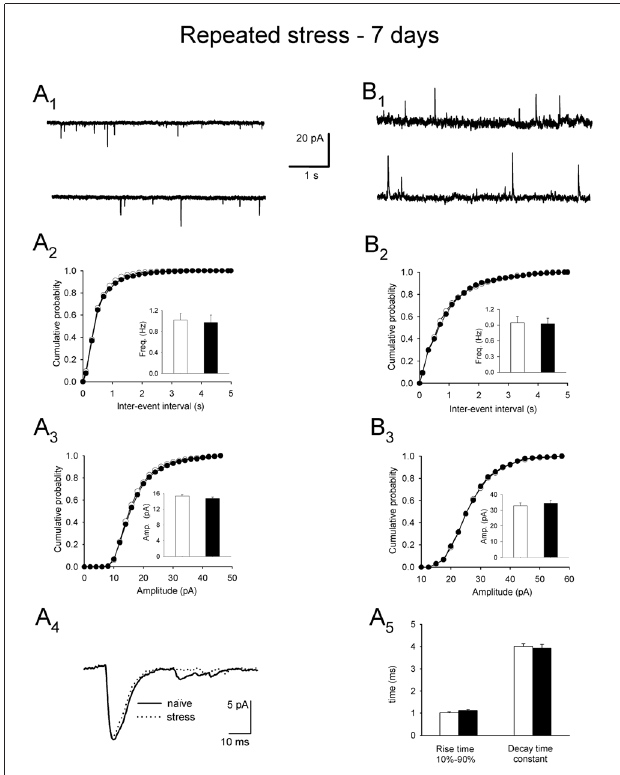
respectively; n = 8 and 8, t = 0.6578, df = 15, p = 0.212). There were also no differences in the mean mEPSC amplitude (15.31 ± 1.121 pA vs. 15.14 ± 0. 894 pA, respectively; n = 9 and 8, t = 0.138, df = 16, 0.768, Figure 6B ). Thus, L-NNA